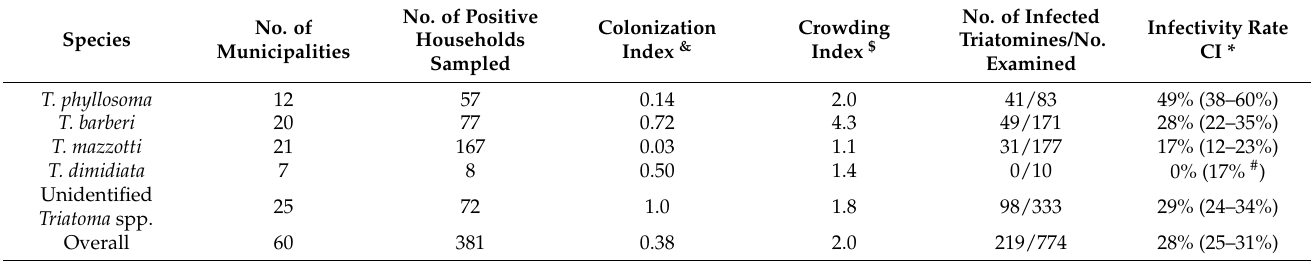
Table 1. Entomological and parasitological indices for the four predominant domestic triatomines of Oaxaca, M é